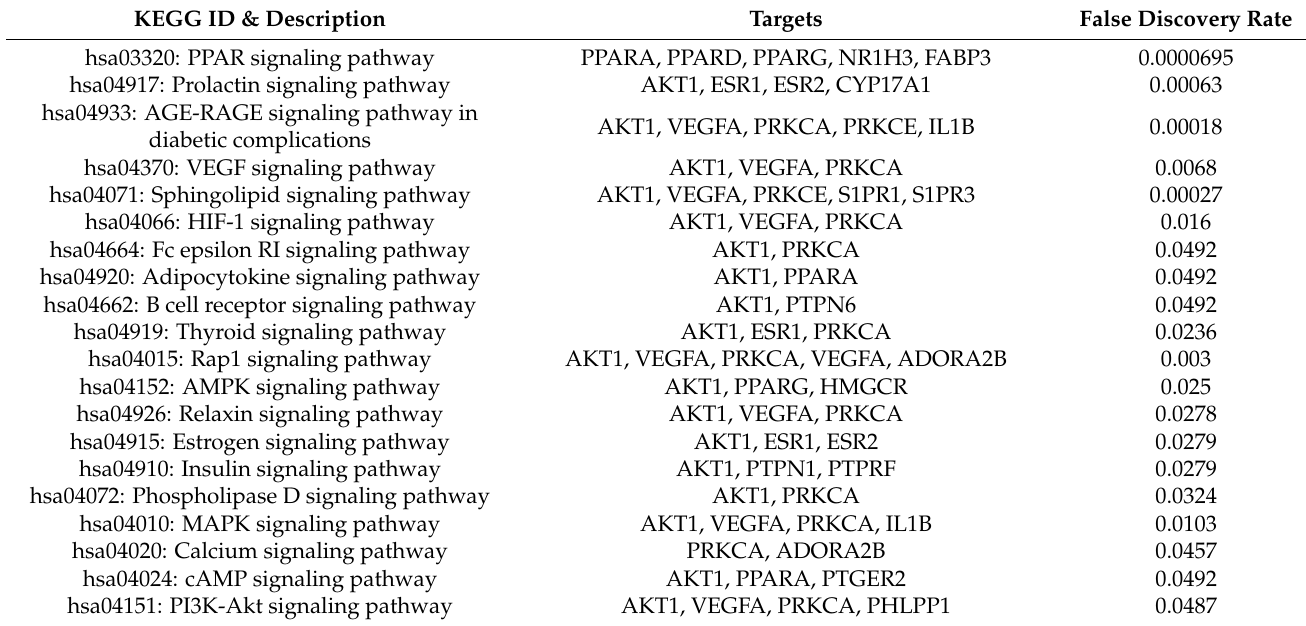
Figure 6. S–T–B networks (63 nodes, 204 edges). Green rectangle: Signaling pathway; pink triangle: Target protein; orange circle: Bioactive. Table 5. Targets in 20 signaling pathways’ enrichment related to